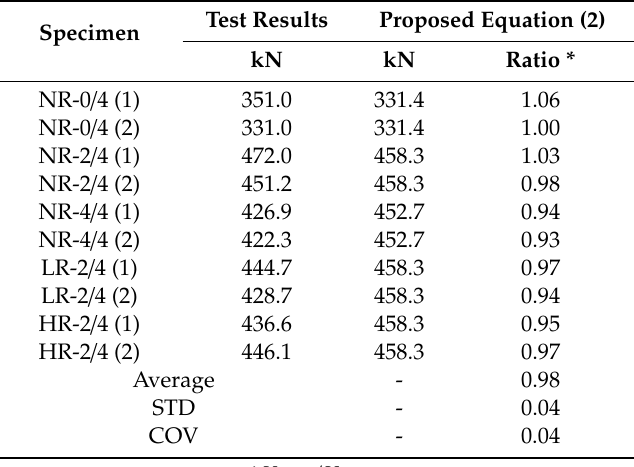
Table 6. Verification results of proposed